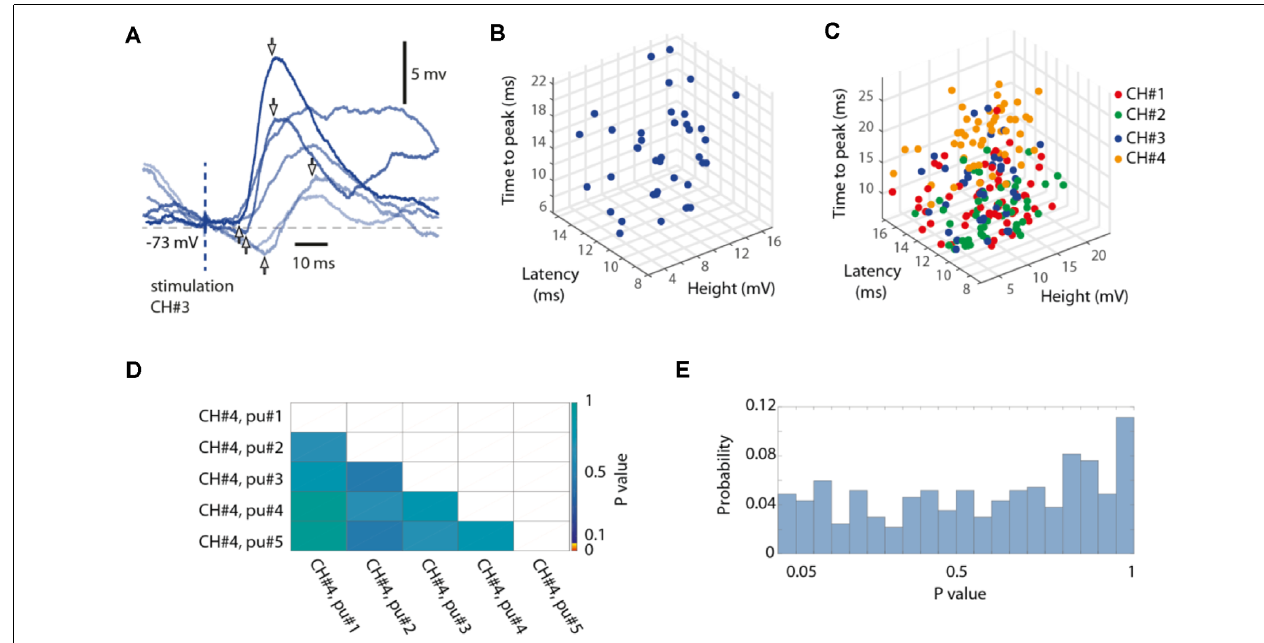
FIGURE 6 | Random variability of the isolated single-pulse responses. (A) Six superimposed raw intracellular traces evoked by isolated single-pulse stimulations to channel #3, recording from Neuron #7. Pairs of arrows indicate the response onset latency time, the time-to-peak and the peak amplitude for three sample responses. (B) 3D plot of the measured parameters for all responses evoked by isolated single-pulse stimulation of channel #3 in the same neuron. (C) Similar display for all four channels used. (D) The matrix presents the outcome of a statistical investigation of whether the rank order of the single-pulse stimulations within the five pulse chunks (each pulse separated by an interval of 0.3 s) had a statistically significant impact on the response amplitude, by comparing the 20 responses of any one group (the first pulse, for example) to those of each other group (the third pulse, for example) in turn (Wilcoxon rank sum test for pairwise comparisons, p -values are indicated according to the color scale). (E) For the investigation of which an example is shown in (D) , this histogram summarizes the result (the distribution of p values) across all stimulation channels and all neurons